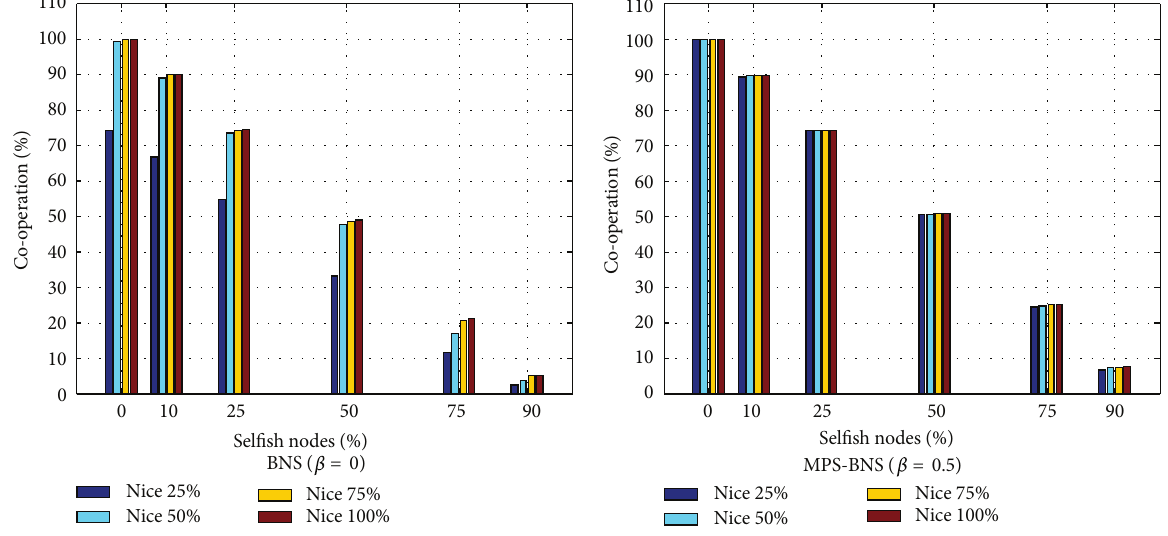
S 9: �evel of cooperation of MPS-BNS with niceness against sel�sh